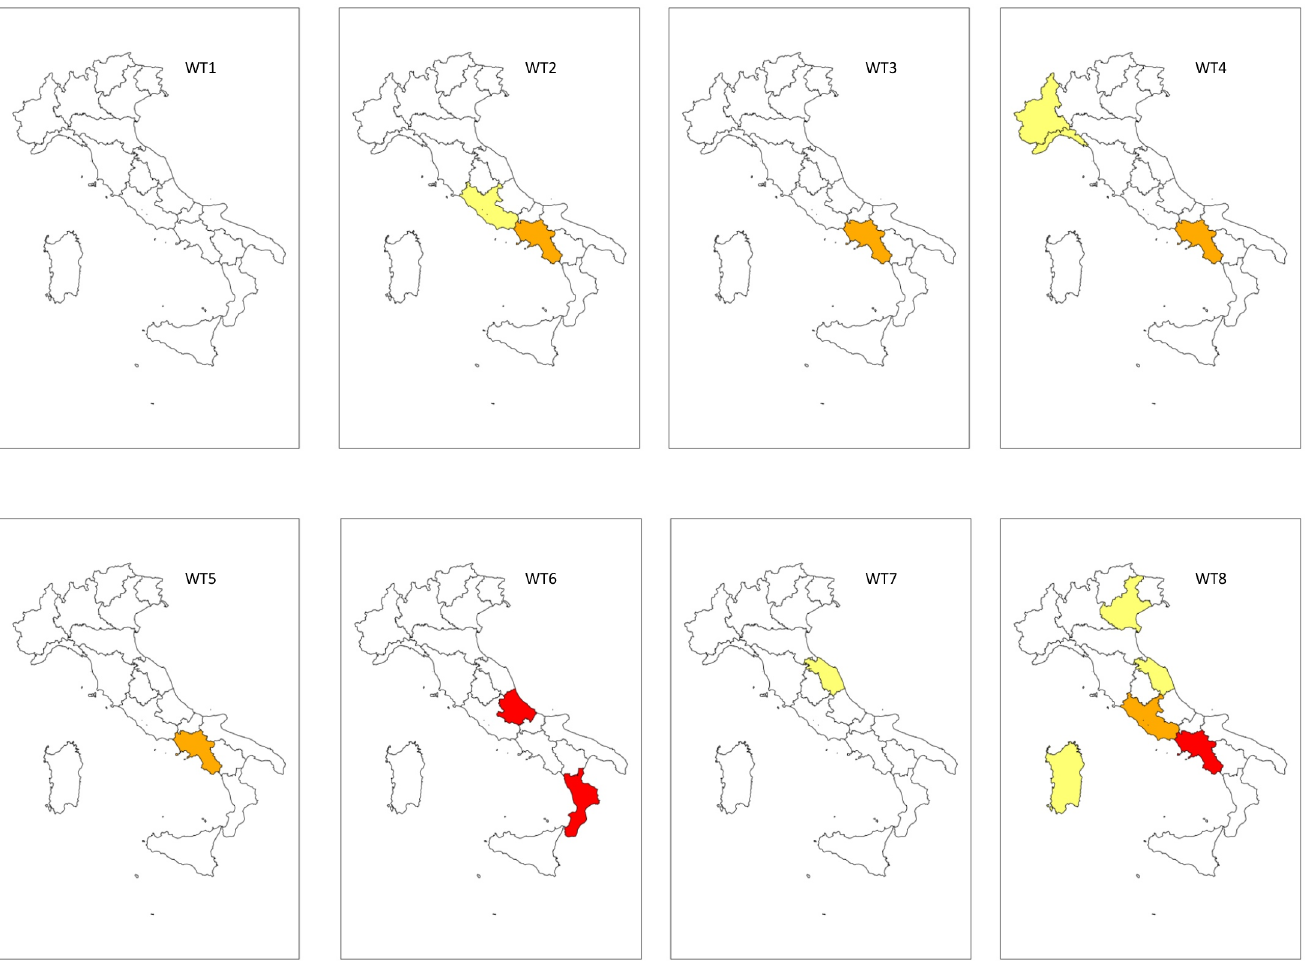
Fig 7. Mapping of the winter WT-related Floods and LAndslides Risk Index (WT-FLARI). WT (Weather Type). WT-FLARI levels: red = Very High (WT-FLARI > 99 th perc.); orange = High (95 th perc. > WT-FLARI > 99 th perc.); yellow = Moderate (95 th perc. > WT-FLARI > 90 th perc.); white = Low (WT-FLARI < 90 th